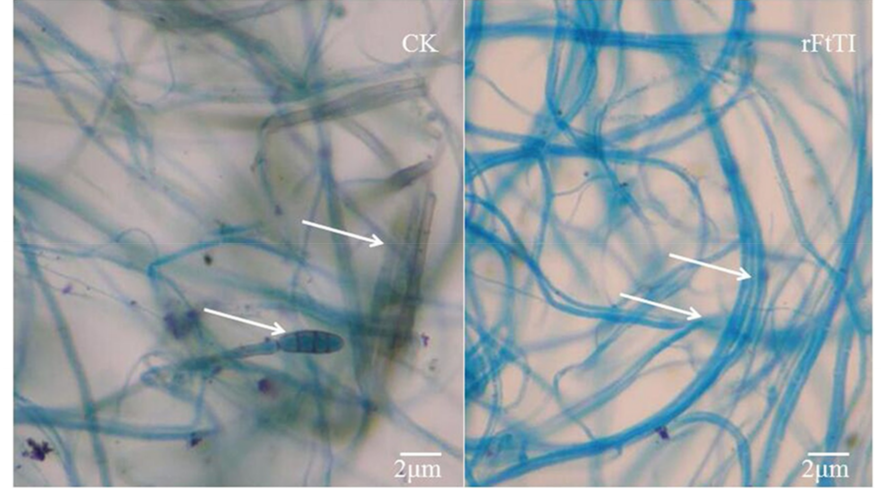
Figure 5. In vitro hyphal morphology studies. Left, hyphal morphology of Alternaria solani in a control well. Right, hyphal morphology of A. solani in a protein-treated well. Deformations of the hyphal tips (arrows) and decreases in mycelial volume compared to the